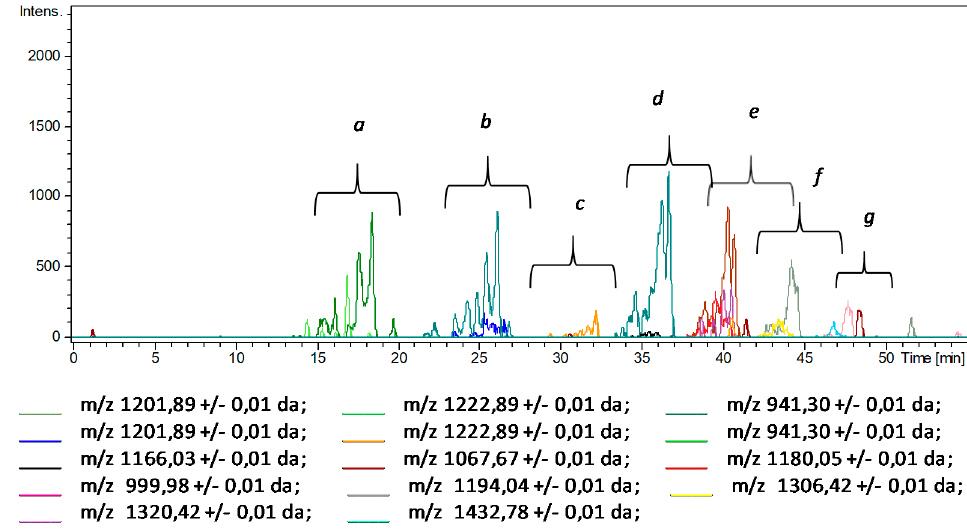
Figure 3. Extracted ion chromatograms (EIC) of mass signals identified as derivatized HA chains (HA-DA) ranging from 5-mer oligomers (Mw ~ 1500) to 20-mer oligomers (Mw ~ 4300) (see Table S2). Table 1. Proton 1 H and carbon 13 C structure-chemical shift assignment of hyaluronic acid (HA) and HA-dopamine (DA). Italics: free DA. The numbers used for the attribution of DA signals refer to the DA structure reported in Figure 4.